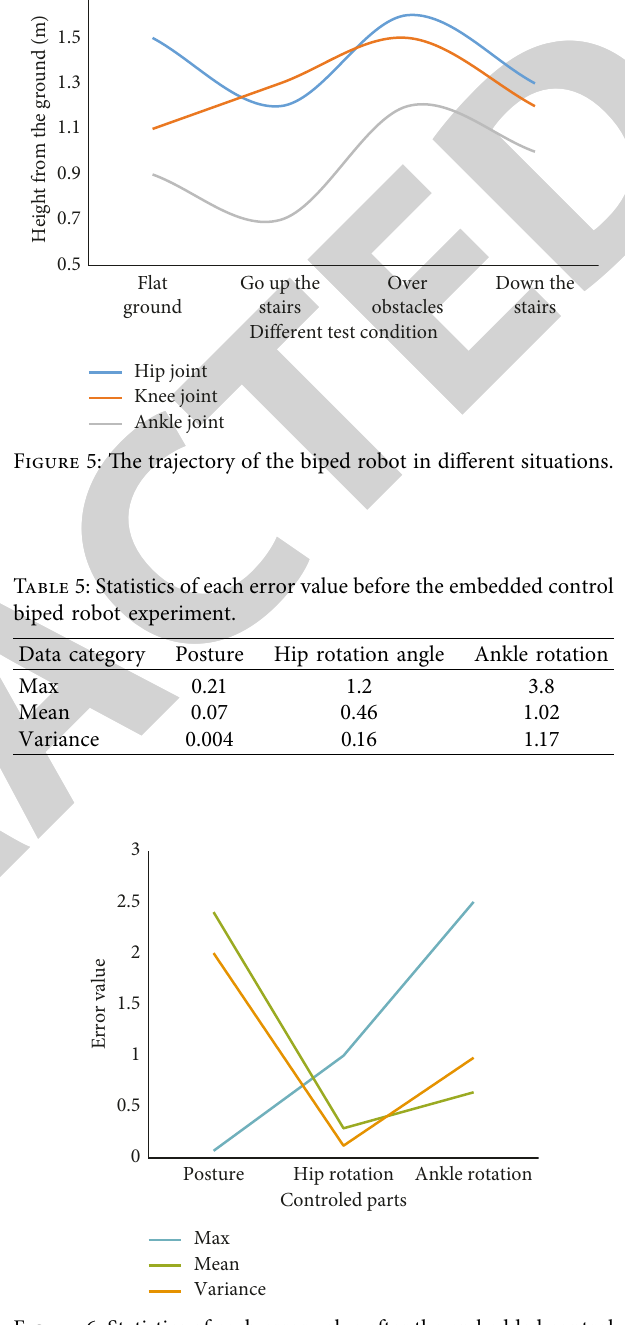
Figure 6: Statistics of each error value after the embedded control biped robot